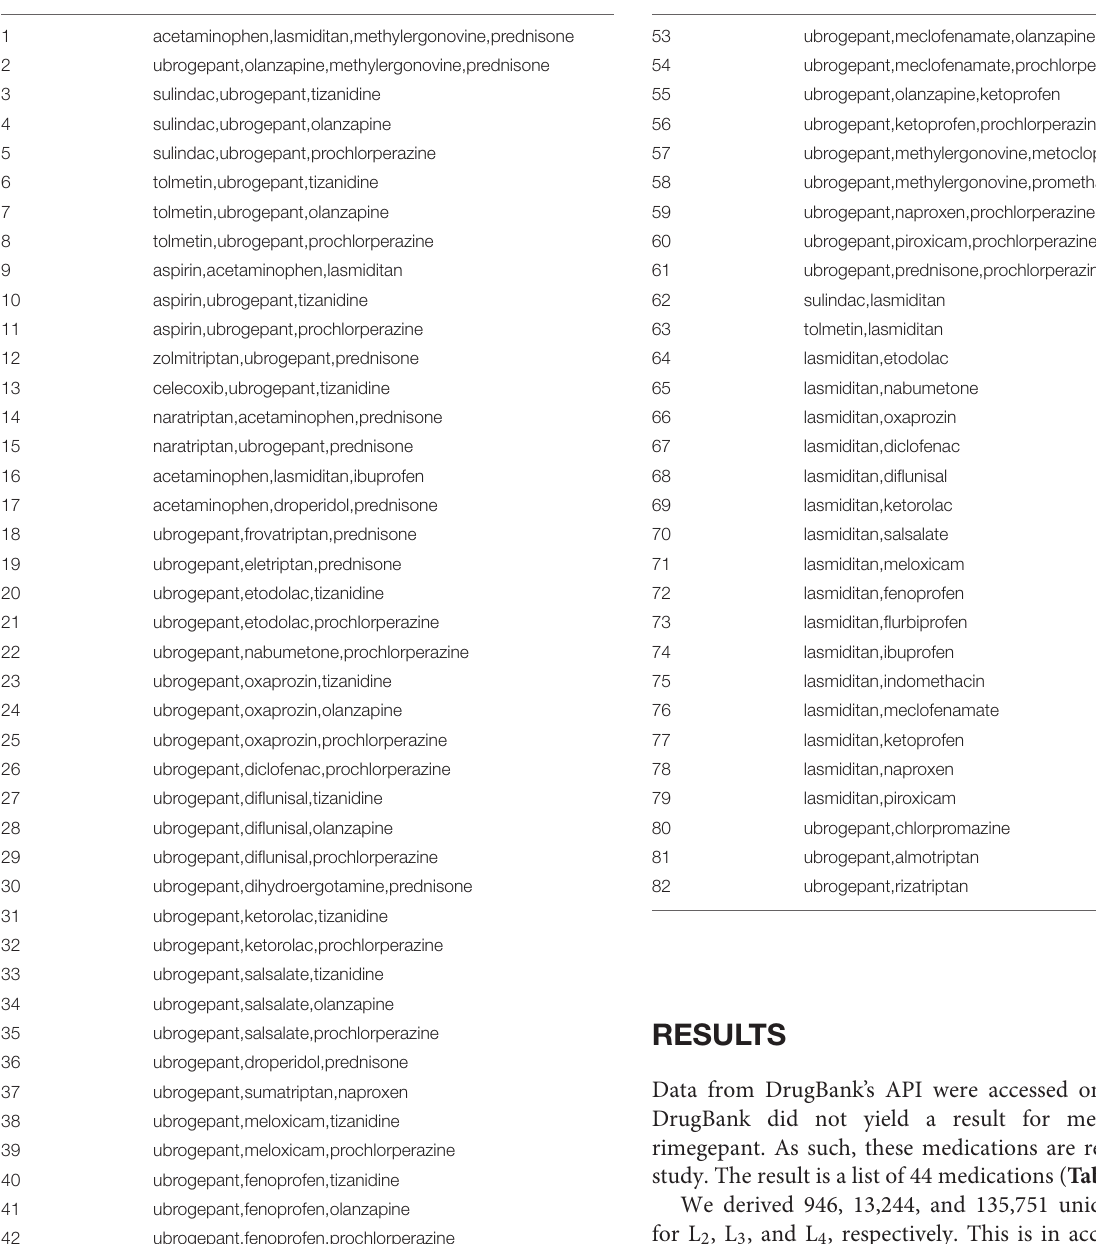
TABLE 2 | Condensed list of abortive medications without